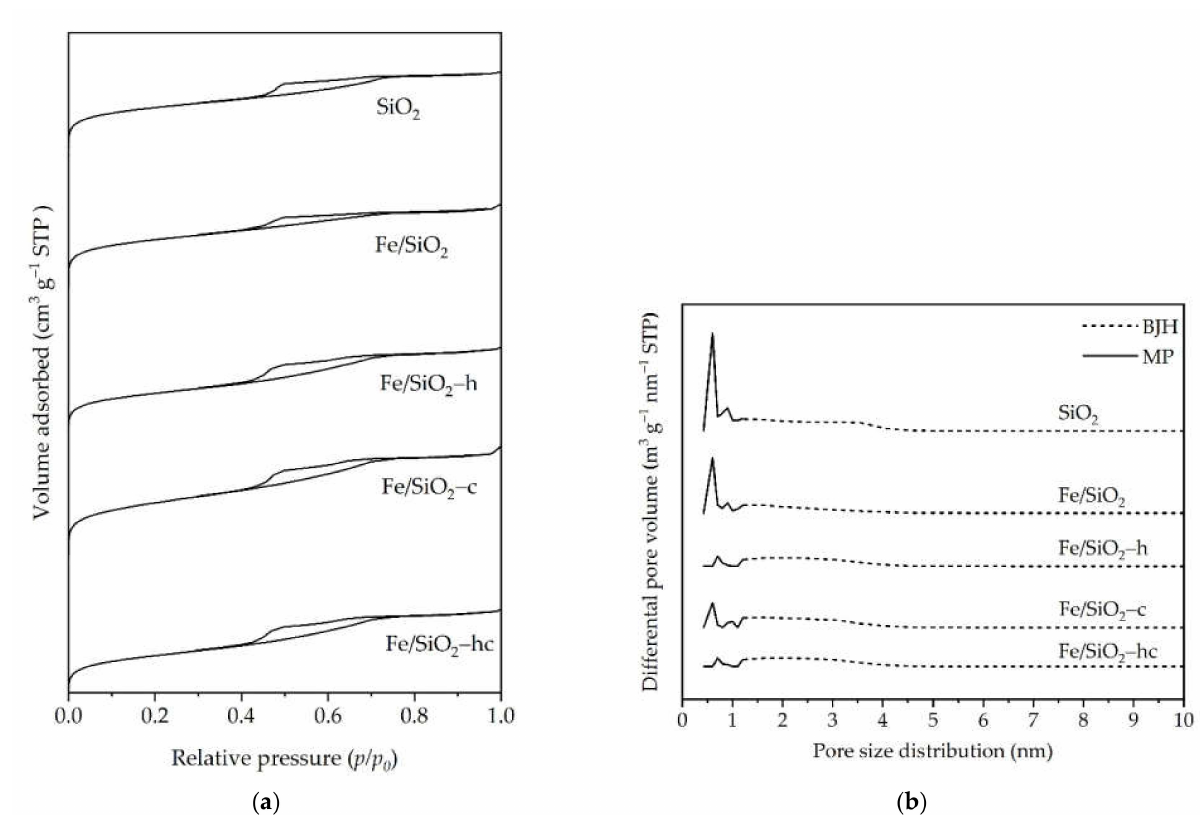
Figure 3. ( a ) N 2 adsorption–desorption isotherms and ( b ) pore volume and size distribution of silica support, the calcined Fe/SiO 2 catalyst, and all activated Fe/SiO 2